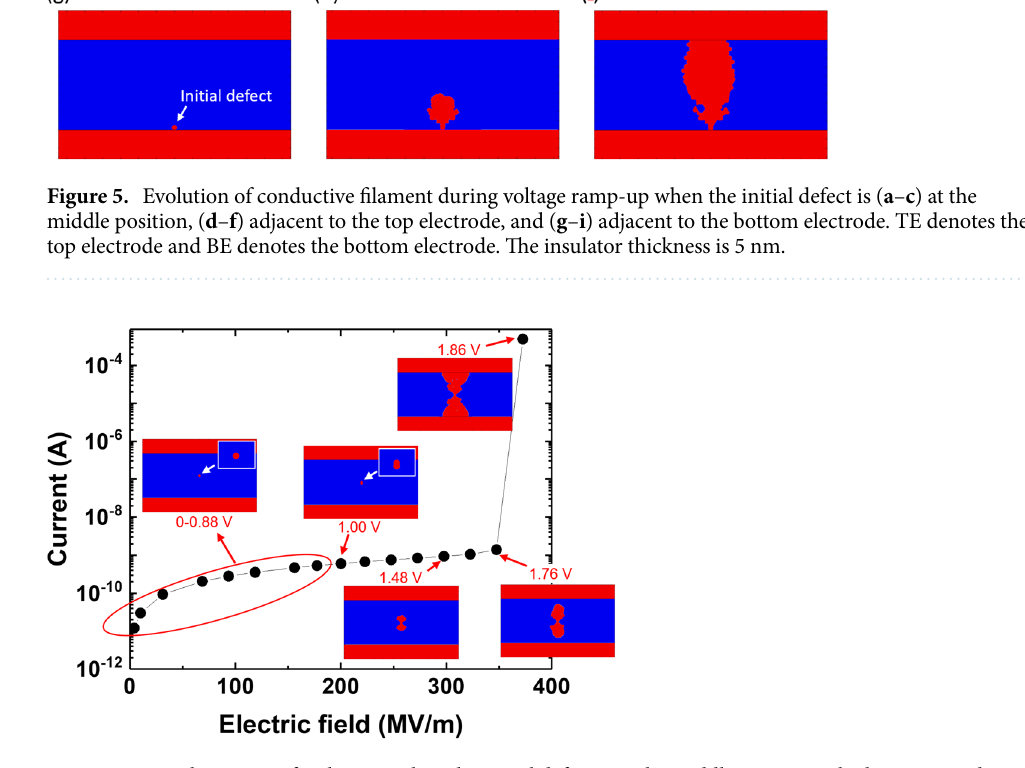
Figure 6. Switching curve for the case when the initial defect is at the middle position, which corresponds to Fig. 4a–c. The evolution of the conductive filament is shown at selected voltages. The initial defect does not change up to 0.88 V, and another defect is generated at 1 V (insets). The insulator thickness is 5